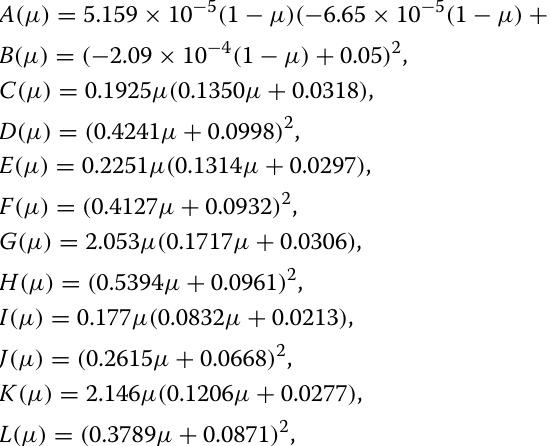
y 6 correspond to strong absorption lines at center frequencies 119 GHz, 183 GHz, 325 GHz, 380 GHz, 439 GHz, and 448 GHz, respectively. This is also visible in the line expressions as the parameters p 1 to p 6 give the line center frequencies in wavenumbers. These parameters are accurate for the whole frequency band 100–450 GHz. However, slightly improved performance between the absorption lines below 200 GHz can be × 10 − 5 × 10 − 4 in the place of 2 in (11). This only has minor achieved by using value 2 impact on very long link distances, such as one kilometer and beyond link